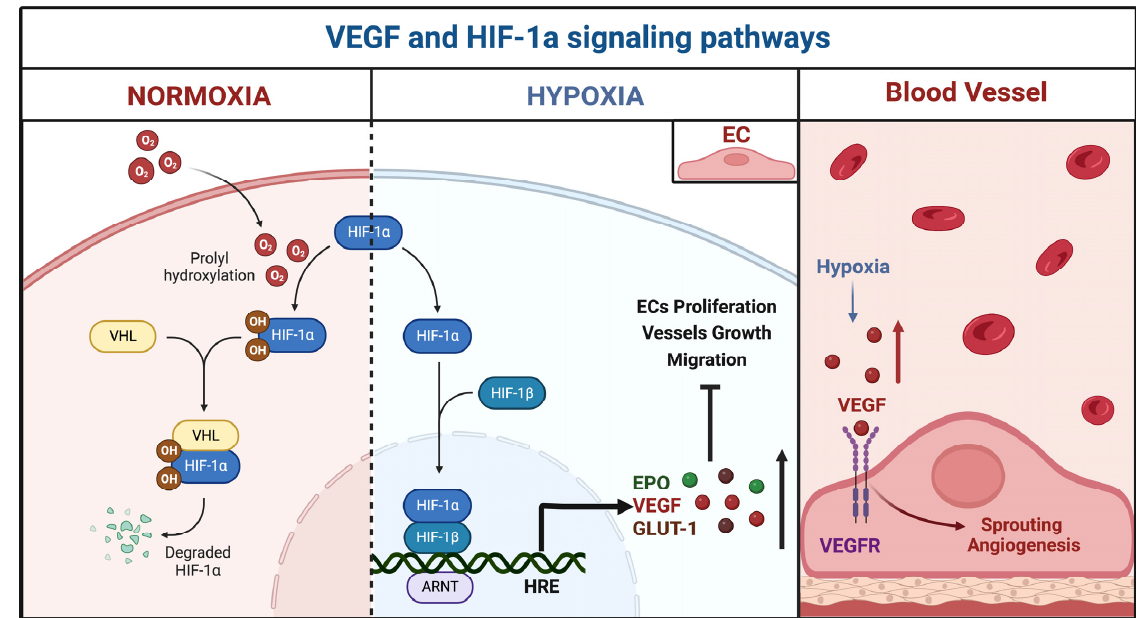
Figure 9. Hypoxia-inducible factor 1 (HIF-1 α ), in normoxia conditions, undergoes hydroxylation at specific prolyl residues. It is identified by the von Hippel–Lindau tumor-suppressor protein (VHL) and this interaction promotes its rapid ubiquitination and degradation. Under hypoxia, the complex HIF-1 α / β , combined with the aryl hydrocarbon receptor nuclear translocator (ARNT) and the transcriptional regulator hypoxia-response element (HRE), induces transcription of erythropoietin (EPO), vascular endothelial growth factor (VEGF), and glucose transporter 1 (GLUT1). These pathways regulate, erythropoiesis, cell metabolism, and migration. Furthermore, the high blood level of VEGF promotes endothelial proliferation and angiogenesis. vascular endothelial growth factor receptor (VEGFR).